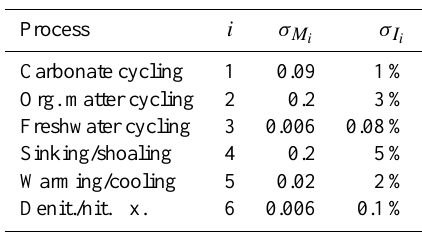
∂X j,i Table A3. ∂(cid:127) C (bold text) and (italic text) terms used in Eq. (A5) for well-equilibrated surface seawater. These terms are specific to ∂X j ∂R i the j = 7 (columns) properties we use to calculate (cid:127) C and i = 6 (rows) processes we consider. Units for ∂(cid:127) C ∂X j,i X j units. Units for are the X j units divided by the R i units given in Table ∂R i